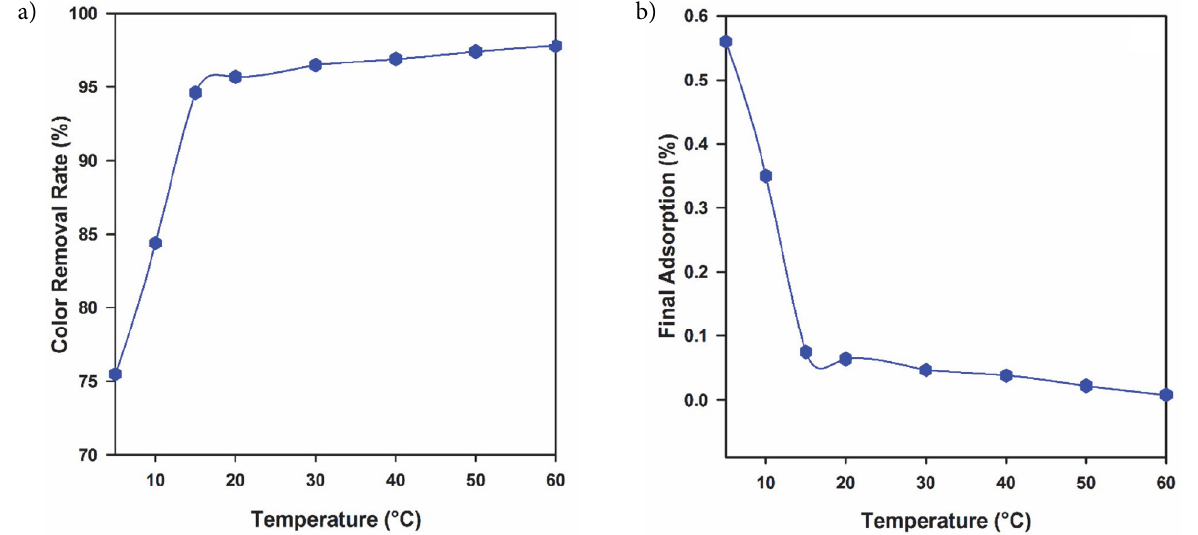
Figure 6. The effect of variable temperature on the (a) dye removal rate and (b) final adsorption of the Erythrosine dye.